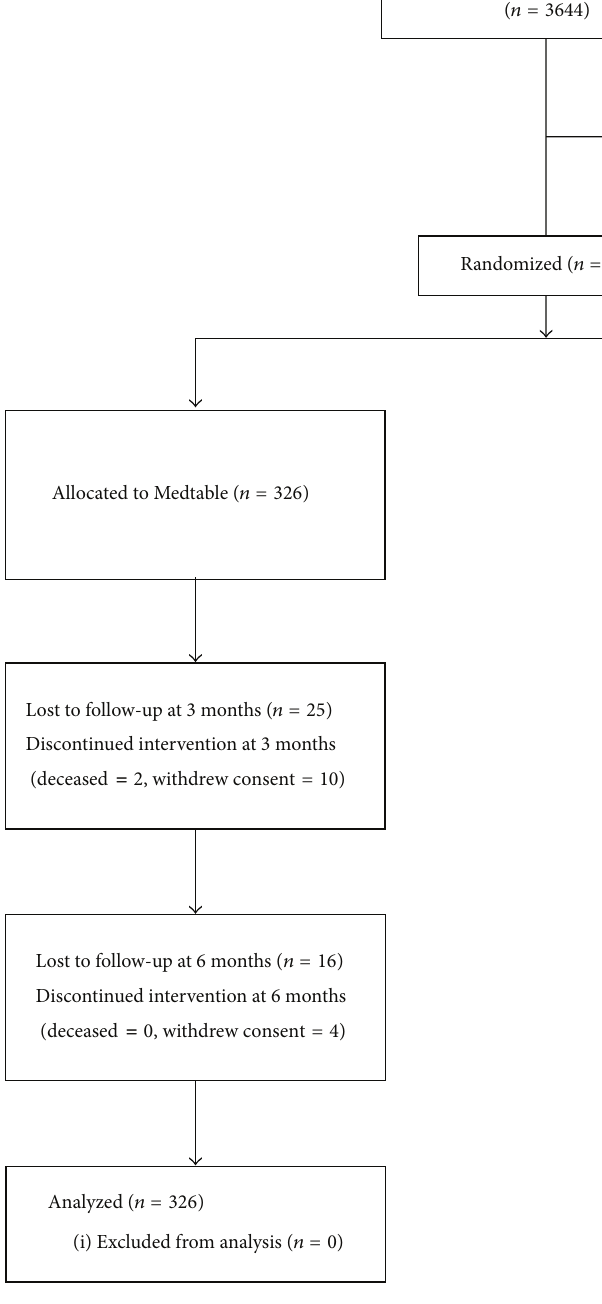
Figure 2: Trial flow